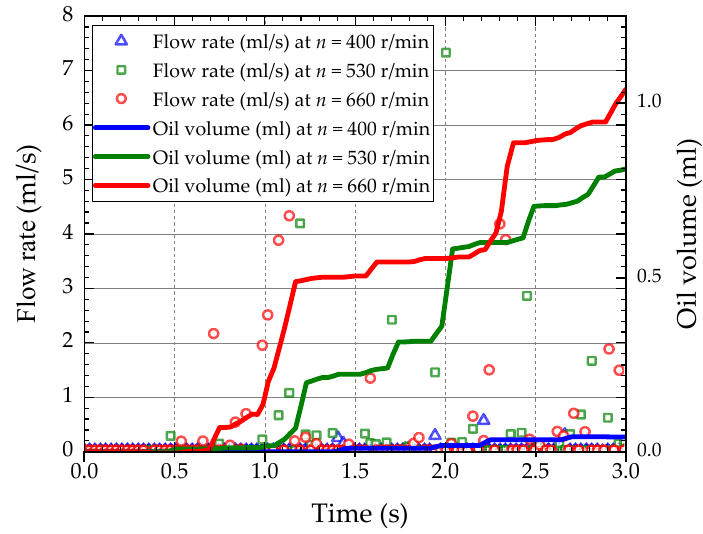
Figure 8. Oil flow rate–oil volume–time curve (Monitoring Plane 1).